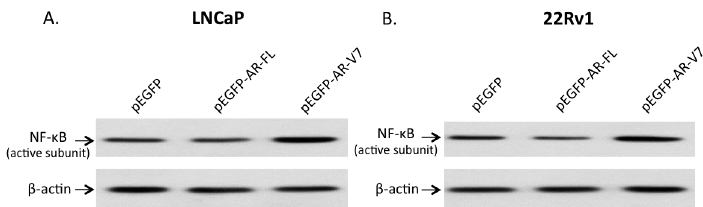
Figure 3. Expression of active subunit of nuclear factor-kappa B (NF- κ B) in transfected prostate cancer cells. LNCaP ( A ) and 22Rv1 ( B ) cells were transfected with pEGFP, pEGFP-AR-FL, or pEGFP-AR-V7 expression plasmids. Immunoblot using an antibody against the active subunit of NF- κ B was carried out on protein lysates from transfected cells. β -actin was used as an internal control.